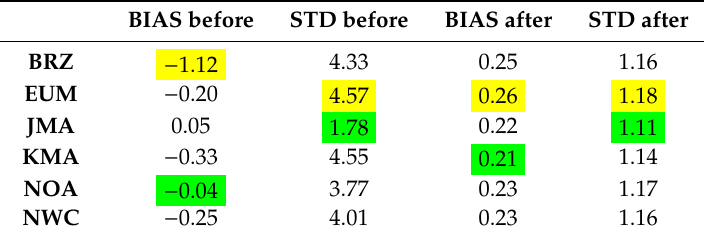
Table 9. The same as Table 8, but with CQI >= 80%.